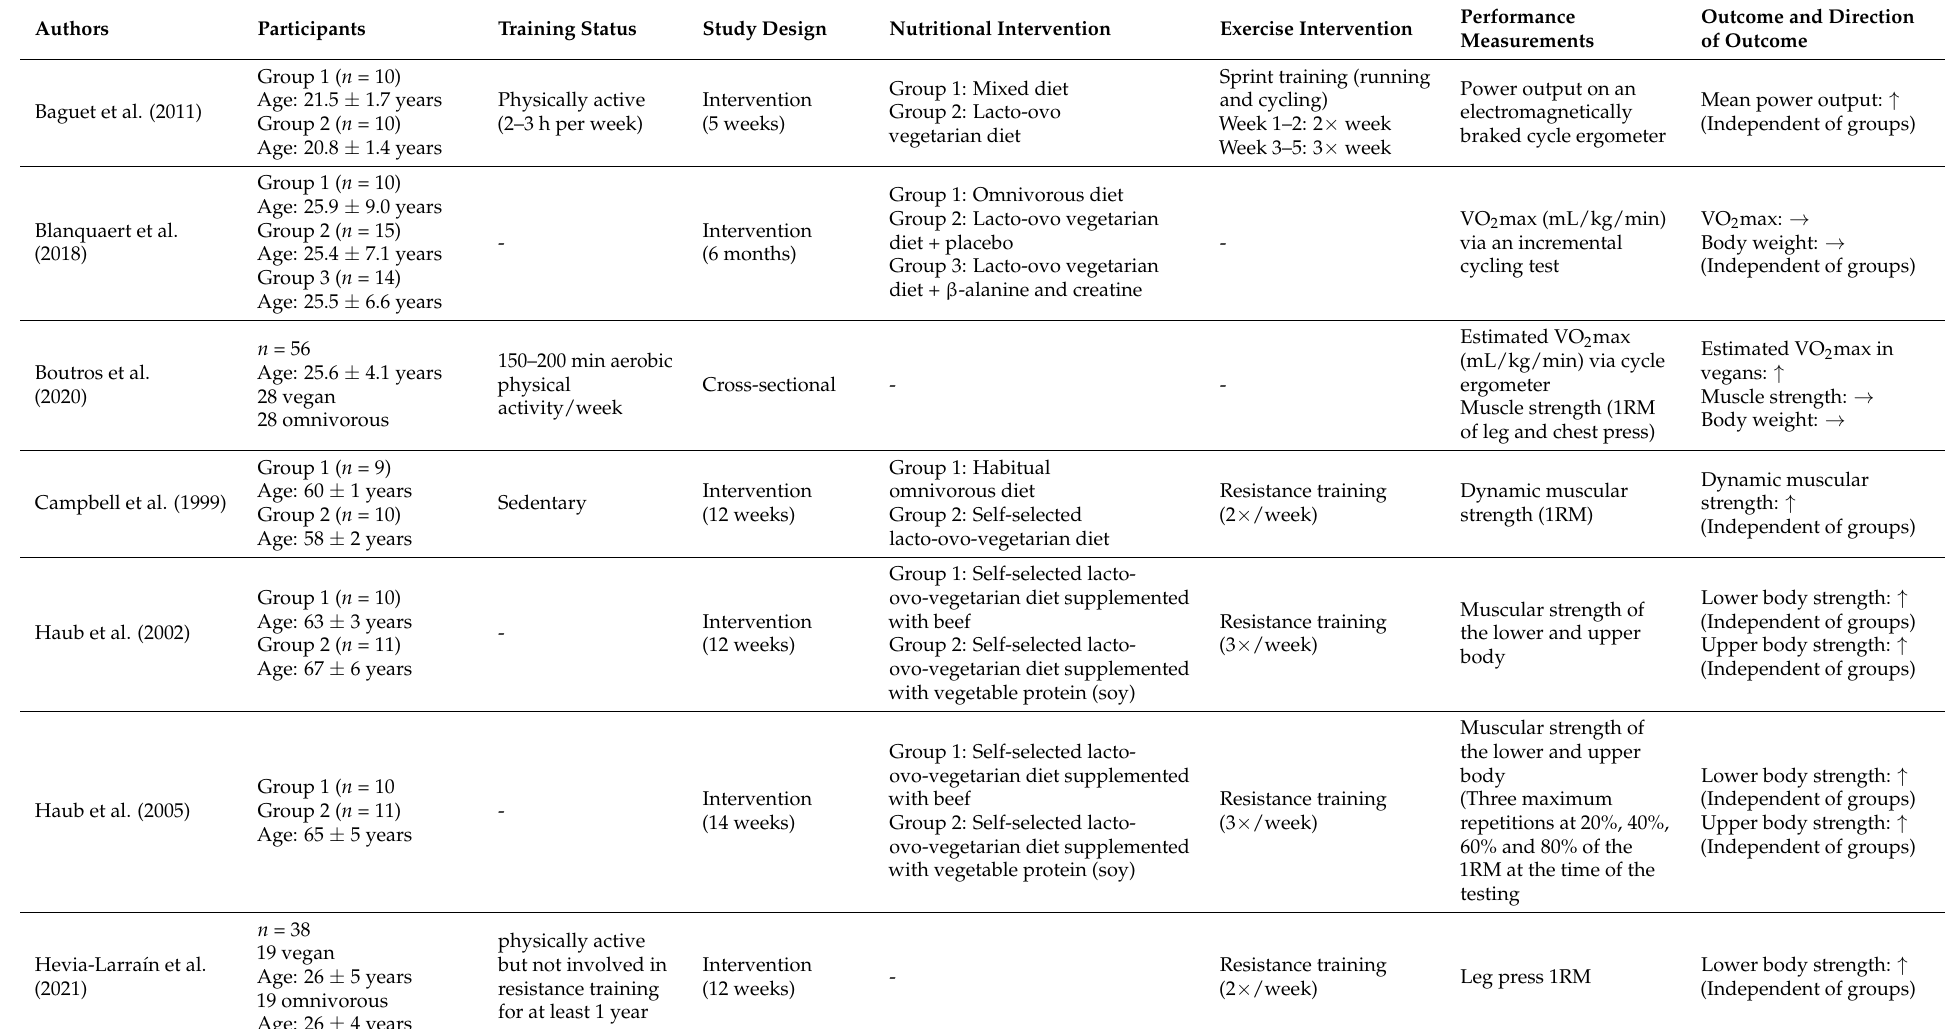
Table 3. Overview of suitable research items. (Arrows indicate an increase ( ↑ ), no change ( → ) or a decrease ( ↓